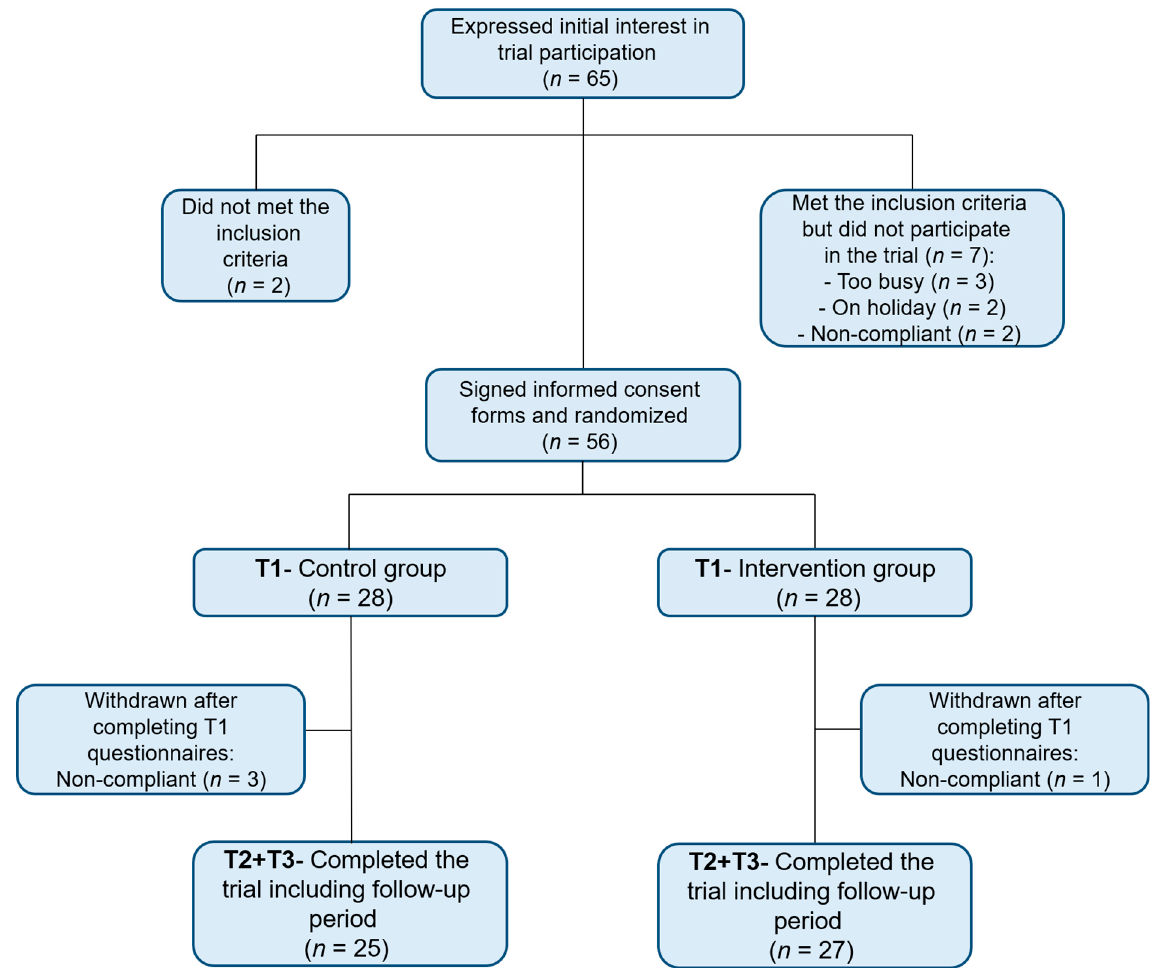
Figure 2. Consort diagram of research flowchart.